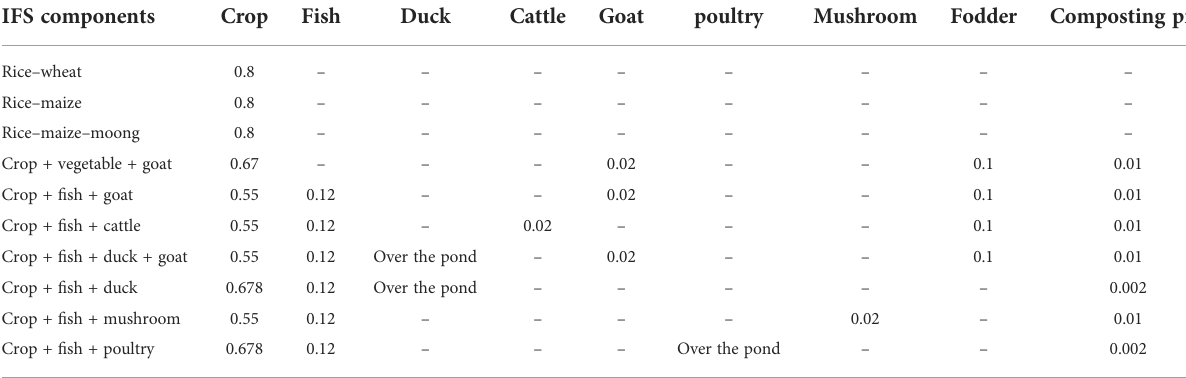
TABLE 2 Land allocation (ha) for different components under farming systems of 0.8 ha area. IFS components Crop Fish Duck Cattle Goat poultry Mushroom